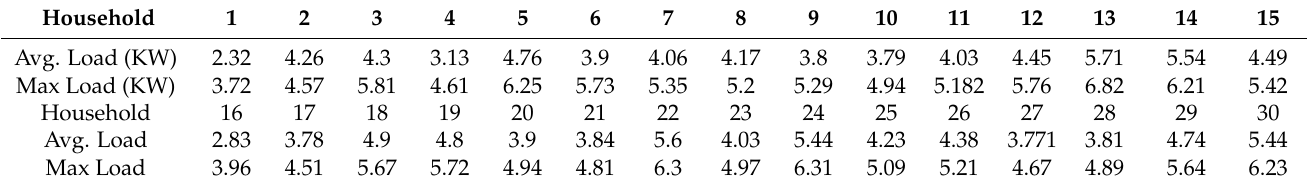
Table 1. Load profiles of